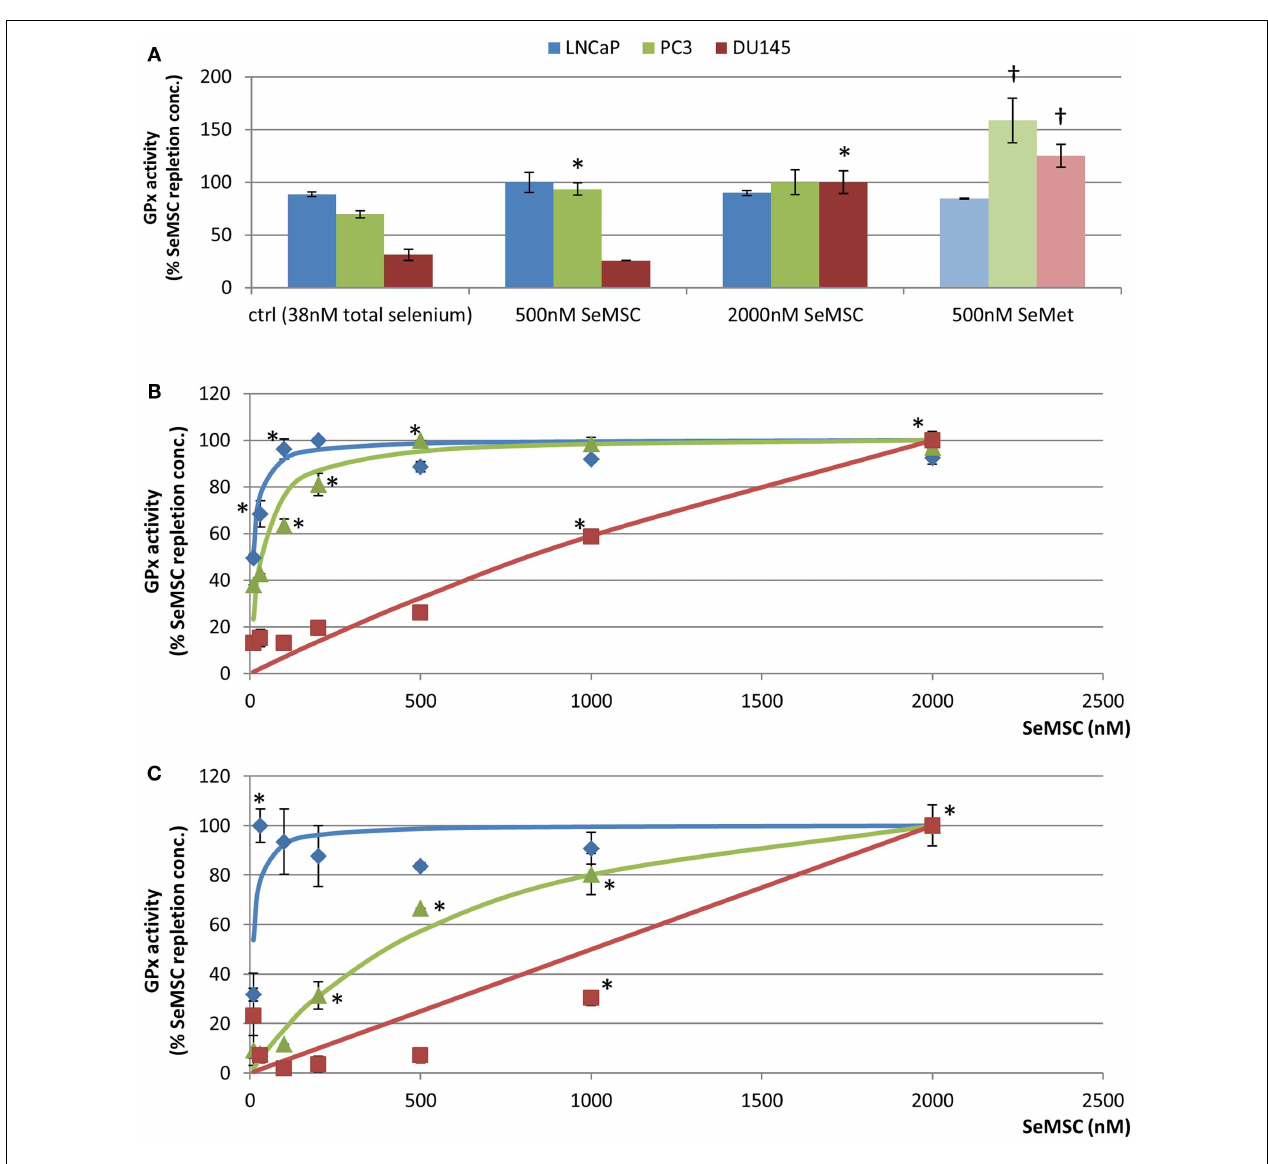
bars ± SD. *Significant increase compared to previous concentration of SeMSC, † significant increase compared to equal SeMSC concentration p < 0.05. Lines represent curve fit using Michaelis–Menten formula [Graphpad Prism 5, y = ( V max × X )/( K m + X )] with (B) LNCaP, V max = 7.38, K m = 9.37, and PC3, V max = 2.27, K m = 33.77, and (C) LNCaP, V max = 24.43, K m = 8.71, and PC3, V max = 4.68, K m =